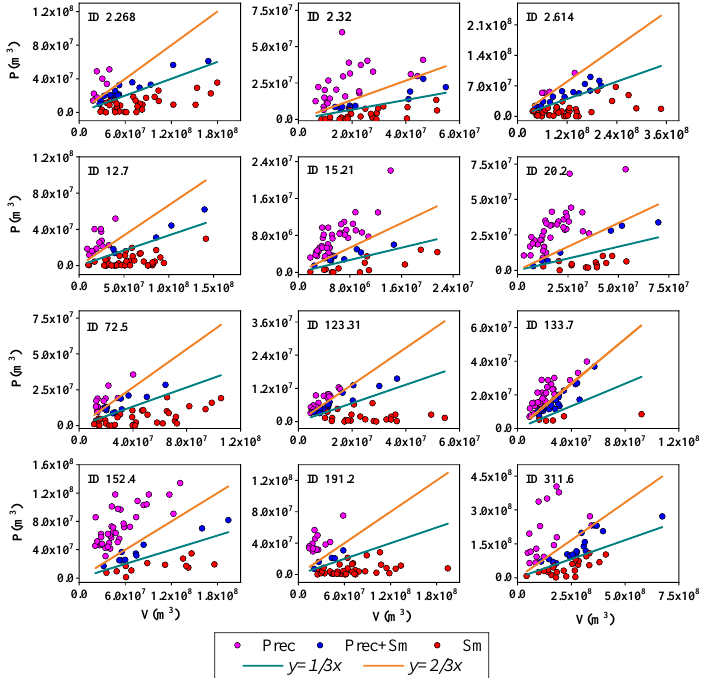
Figure 3. Classification results of FGMs using the rainfall – flood ratio indicators. The flood events are classified by rainfall – flood ratio, indicated by 1/3 and 2/3 lines. Pink dots represent floods caused by rainfall, blue dots represent the interaction of rainfall and snowmelt, and red dots represent floods induced by snowmelt.